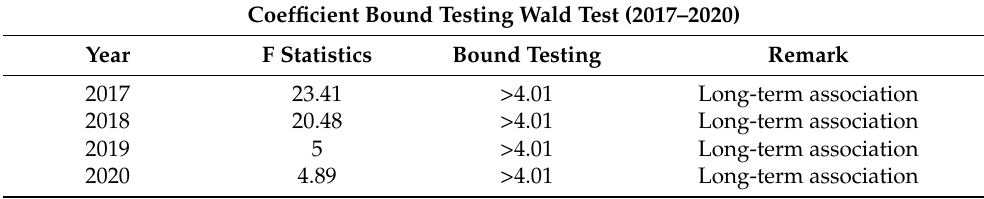
Table 5. F Statistics of bound testing Wald test